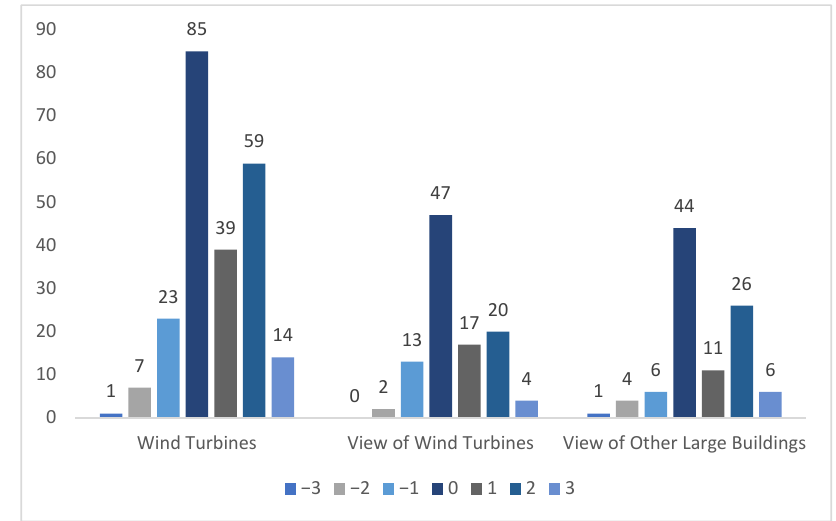
Figure 7. Evaluation of wind turbines and other large buildings.